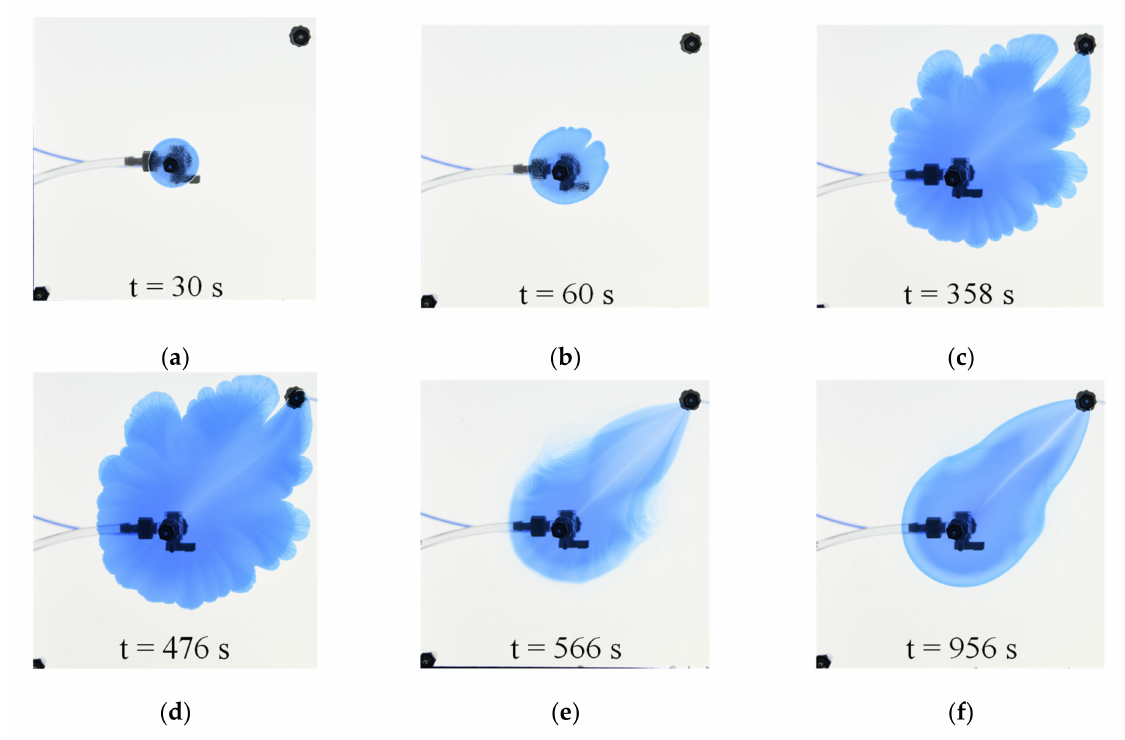
Figure 5. Flow regime at 1.0 mL/min with constant pressure control at the